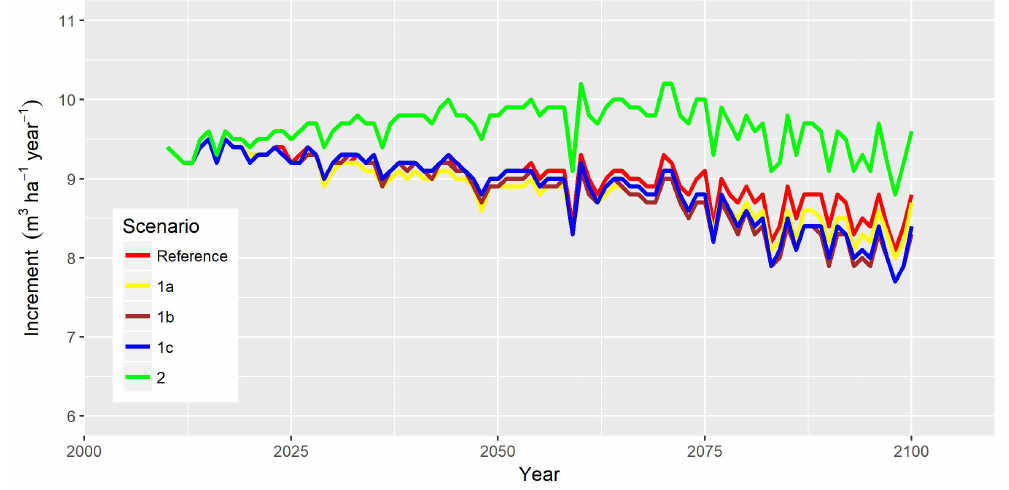
Figure 4. Development of the current increment in different forest management